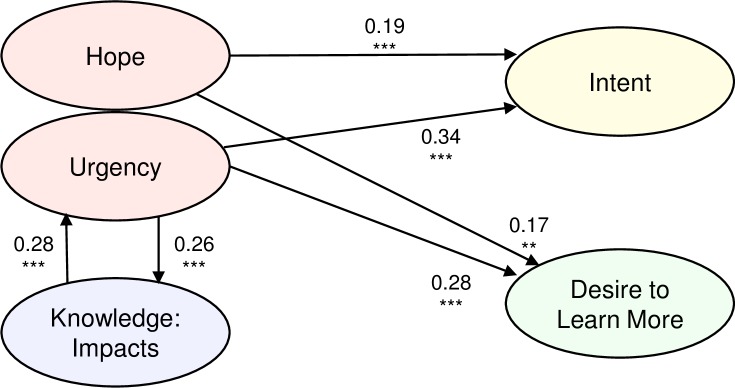
Summary of regression results, showing statistically significant relationships (arrows) among gains in constructs, including affect (Urgency and Hope), knowledge about Impacts, Intent to act and Desire to Learn More.Results are for Model 1 (no participant- or session-level fixed effects; values for Models 2–4 with different sets of controls are similar). Lines with arrows depict statistically significant relationships between independent and dependent variables, with standardized beta coefficients for each relationship shown. See S1 Table for detailed regression results. *** p < 1E-9 denotes statistical significance at α < 0.001 after Bonferroni correction. ** Beta coefficients were statistically significant at α < 0.01 after Bonferroni correction, with p < 1E-6.